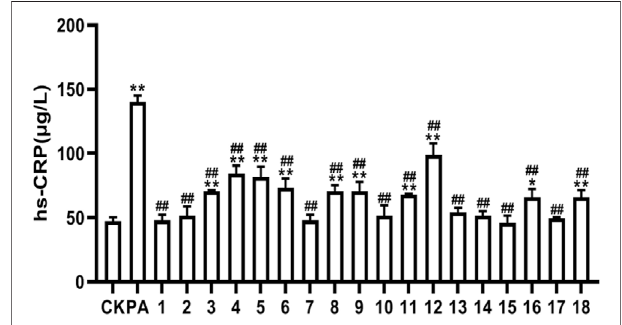
FIGURE 3 | Hs-CRP concentration of 18 batches among BBTD samples.